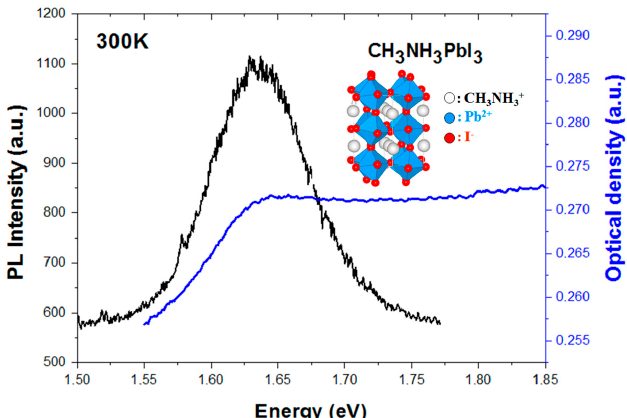
Figure 3. Absorption spectrum (blue curve) and photoluminescence spectrum (black curve) of a 800 nm thick MAPI layer at room temperature, taken just after the deposition by spin-coating (t = 0). The excitation wavelength is 3.815 eV (325 nm, HeCd laser). The inset exhibits the molecular structure of CH 3 NH 3 PbI 3 (MAPI).